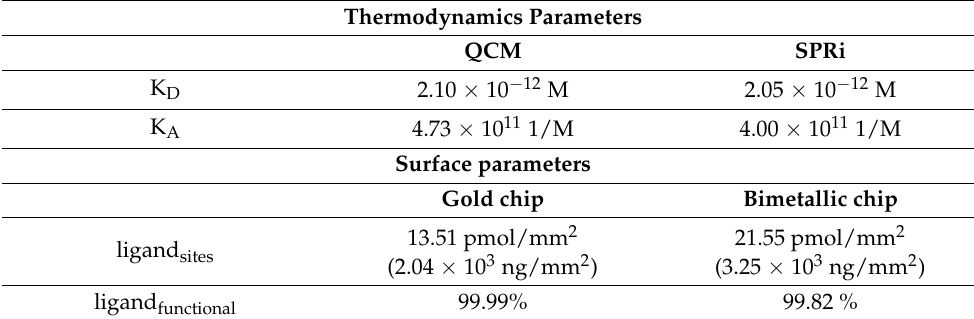
Table 5. Summary of the characteristics of the tested biological system.